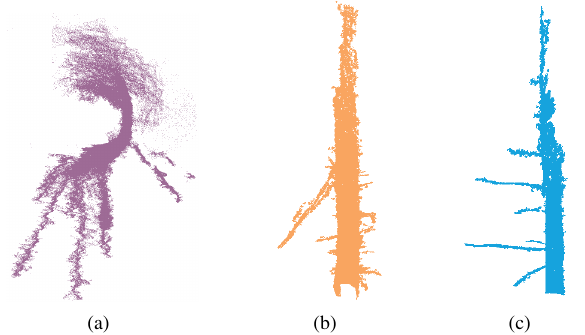
Figure 2: Photogrammetric point clouds of single stems with side branches: (a) top view, (b)-(c) side view.